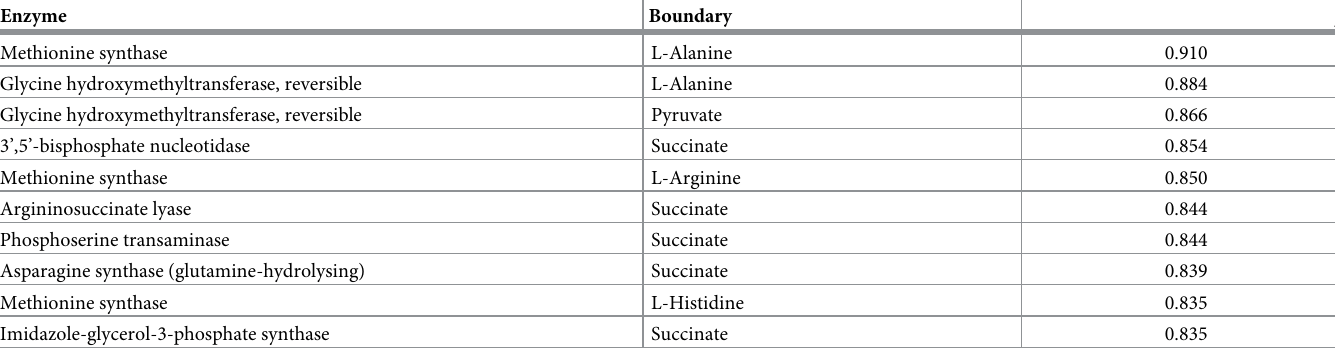
Table 1. Largest significant correlations between measured enzymes and measured boundary fluxes. Enzyme